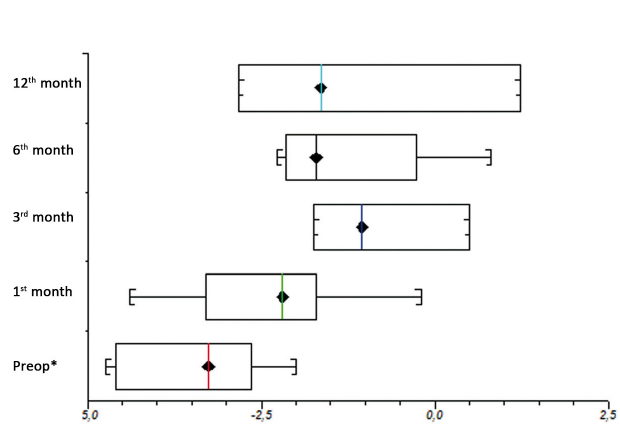
Fig. 10 - Evolution of z-scores for triceps skinfold/age (TSFAZ) in cardiac patients with TSFAZ in the preoperative period which was below the normal pattern of development. Analysis of variance with P=0.054. (*) The TSFAZ was significantly lower when compared